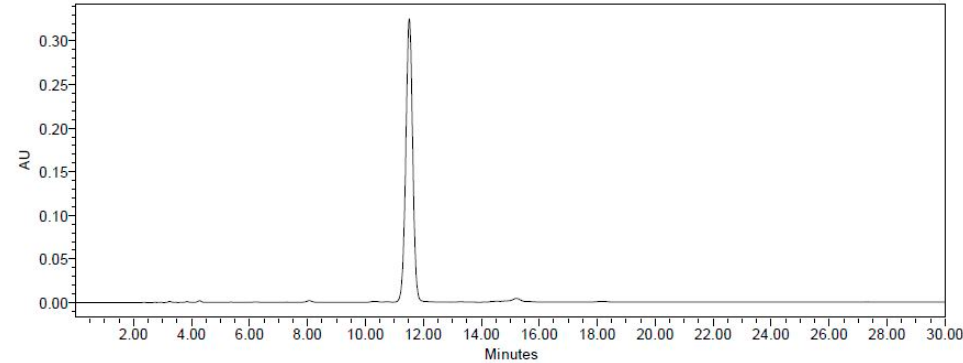
Figure 3. The HPLC chromatogram of 2,3,5,4 ′ -tetrahydroxystilbene-2- O - β - D -glucoside. Column: LiChrospher 100 RP-18e (4 mm × 250 mm, 5 μ m); Mobile phase: 0.05%TFA-CH 3 CN (83:17); Flow rate: 1.0 mL/min; Column temperature: 40 ℃ ; Detection: 320 nm.